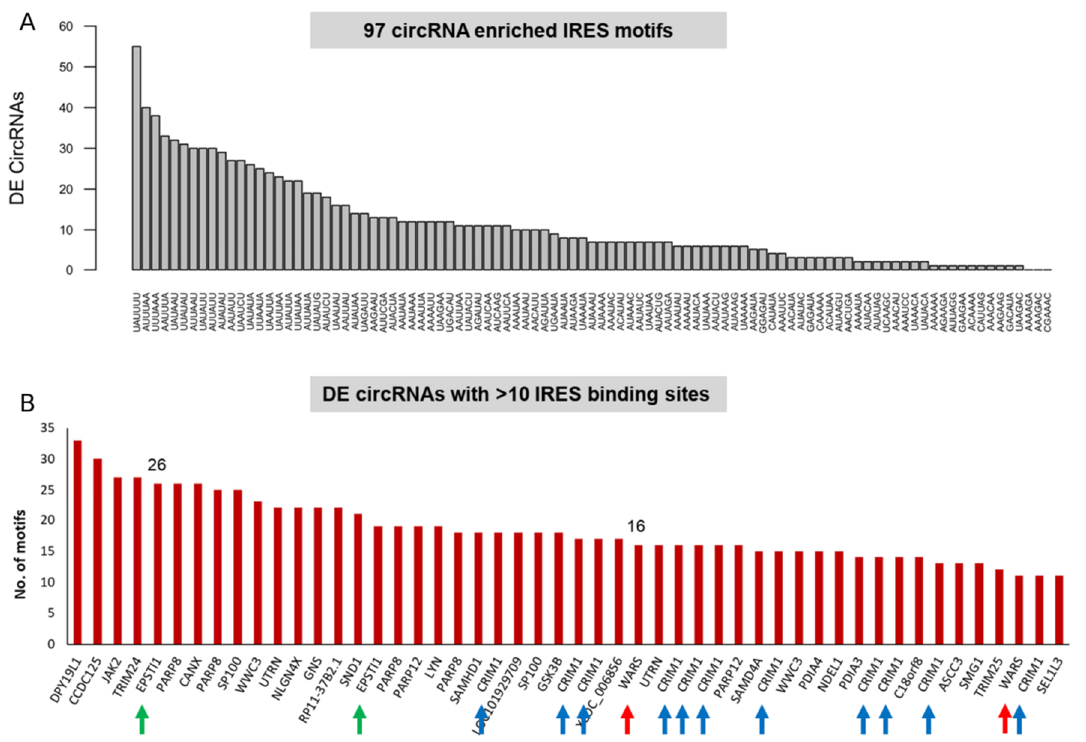
Figure 5. DE circRNAs are enriched in IRES elements. ( A ) The distribution of DE circRNAs that harbor circRNA-enriched IRES motifs. The x -axis shows the 96 circRNA-enriched IRES motifs, and the y -axis shows the number of DE circRNAs harboring these motifs. ( B ) DE circRNAs harboring more than 10 IRES binding sites, highlighting their protein-coding potential. Arrows indicate the binding sites belonging to the three validated candidates.